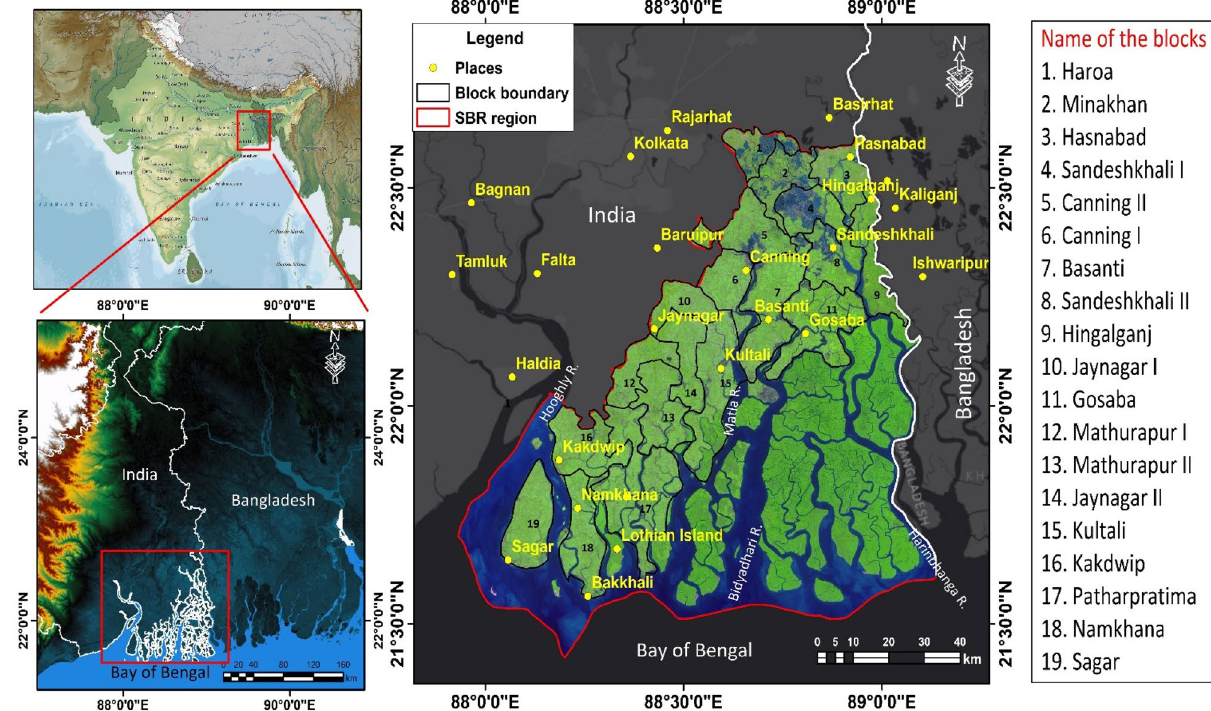
Figure 1. Geographical location of the Sundarban biosphere reserve. The maps were prepared using ArcGIS 10.3 software [https:// deskt op. arcgis. Assessment of land use land cover transformation within the time frame. Total six Landsat images (two MSS (Multispectral scanner), two ETM + (Thematic mapper) and two OLI (Operational land imager)) have been used to classify the study region into different ecosystem unit for the year 1975, 2000 and 2020. MSS of 1975 (path/rows 148/44 and 148/45, 60 m spatial resolution and four spectral bands), ETM + of 2000 (path/rows 138/44 and 138/45, 30 m spatial resolution and eight spectral bands) and OLI_TIRS of 2020 (path/rows 138/44 and 138/45, 30 m spatial resolution and eleven spectral bands) have been retrieved from USGS website (Table S2). Two MSS images, two ETM + images and two OLI_TIRS have been combined sepa- rately in Erdas Imagine software. All satellite images are taken in pre monsoon period (Feb-May) due to cloud- less observation. Dark object subtraction method has been used here and it is very much effective for haze reduction process. Maximum likelihood classification algorithm has been applied for classification of the entire study region into six different ecosystem units (water body including river/creeks, settlement, cropland, man- grove forest, sparse/open vegetation and fallow land) (Fig. 2). Total 250 random points have been created within the Sundarban biosphere reserve (SBR) and validate it through high accuracy Google Earth satellite image and an error matrix has been developed for accuracy assessment. The transformation intensity of each LULC classes has been measured as follows, 100 LULC end year − LULC start year ∗ (1) Transformation intensity = LULC start year t period